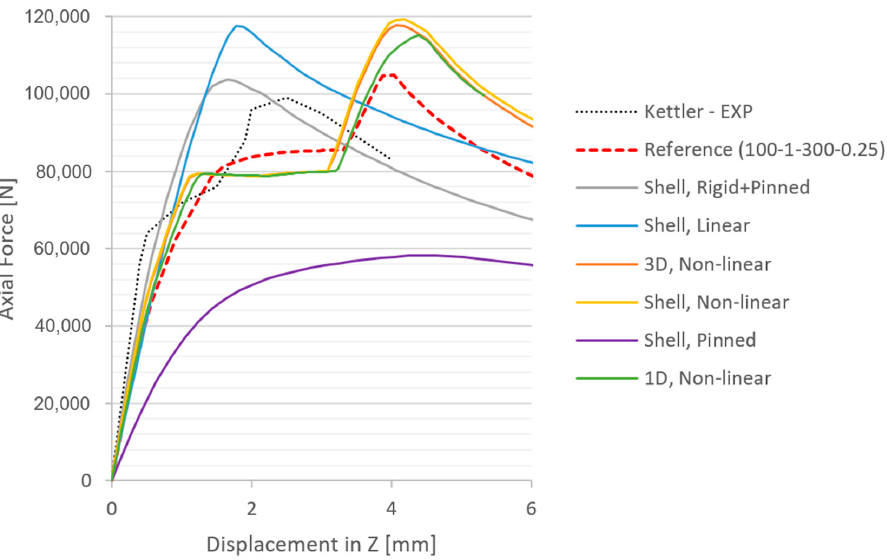
Figure 9. Axial force–displacement curves of the stiffness models compared to the experiment [10] and the reference (100-1-300-0.25).